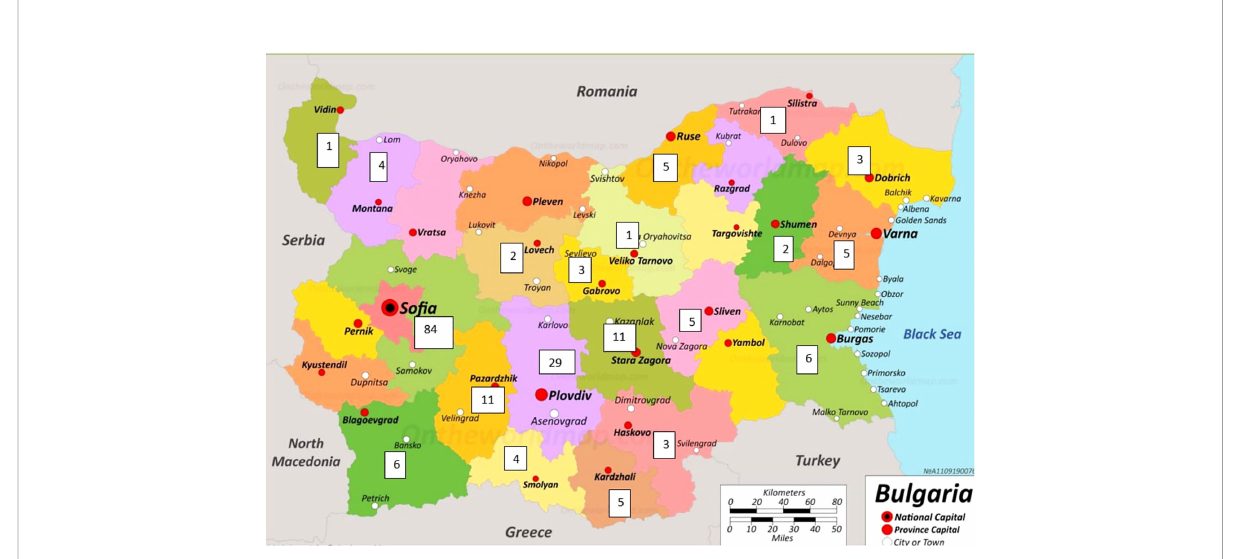
FIGURE 3 Geographical distribution of registered PID patients in Bulgaria (The map was adapted from https://ontheworldmap.com/bulgaria/).